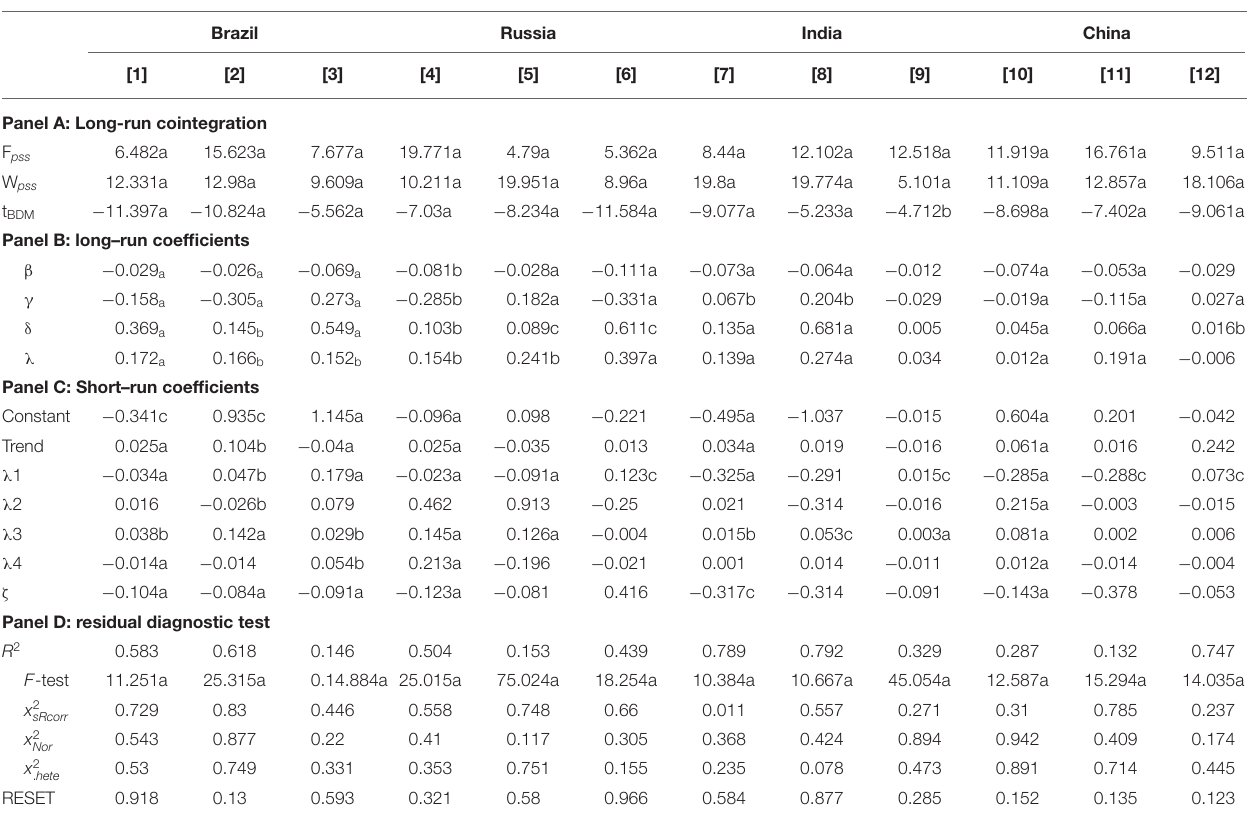
TABLE 4 | Linear ARDL estimation